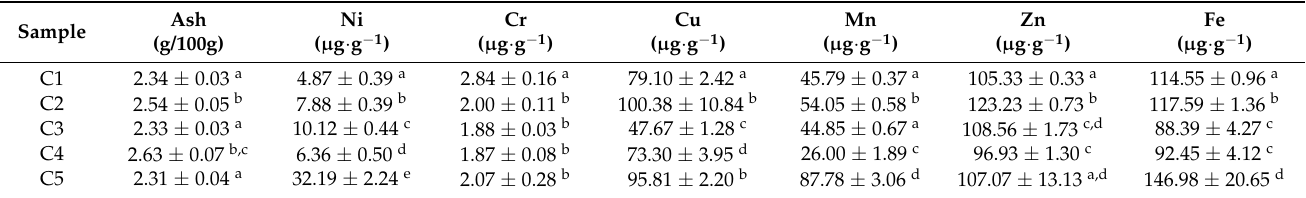
Table 3. Ash content and metal concentration in C1–C5 hazelnut samples (mean